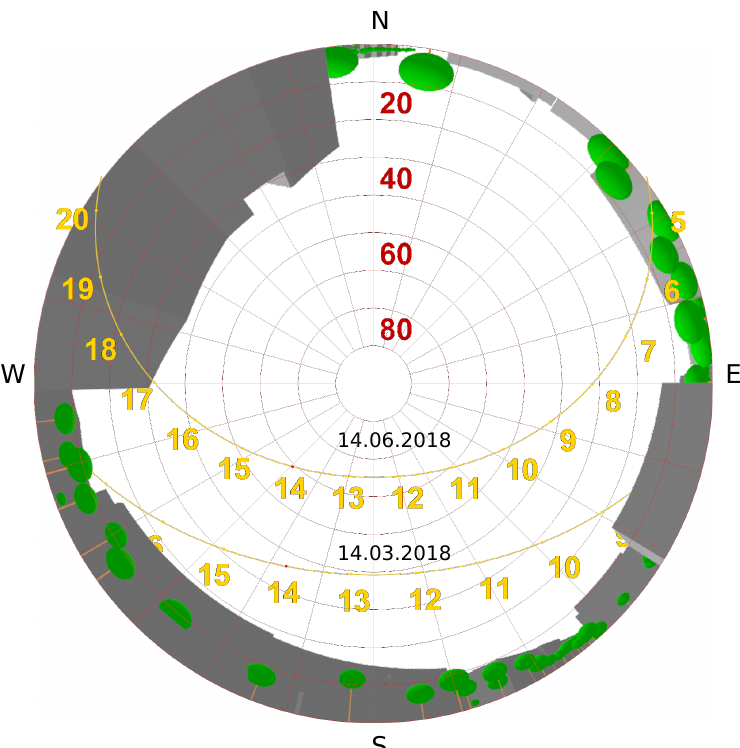
Figure 8. Comparison of sunpath for 14th of March and June for the center of the urban district Rieselfeld in Freiburg, Germany. The sunrise in March is later compared to June, while the sunset occurs earlier in March. The maximal solar altitude angle in June is greater compared to